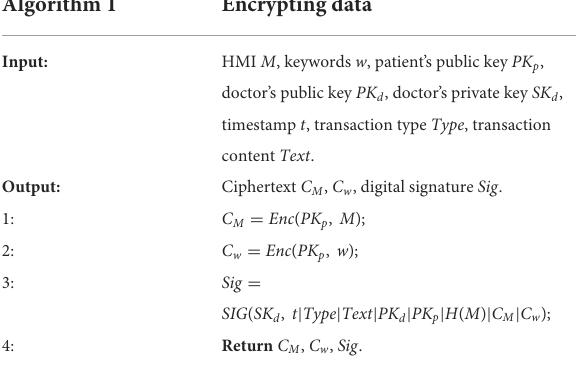
TABLE 3 Pseudocode of decrypting data. Algorithm 2 Decrypting data